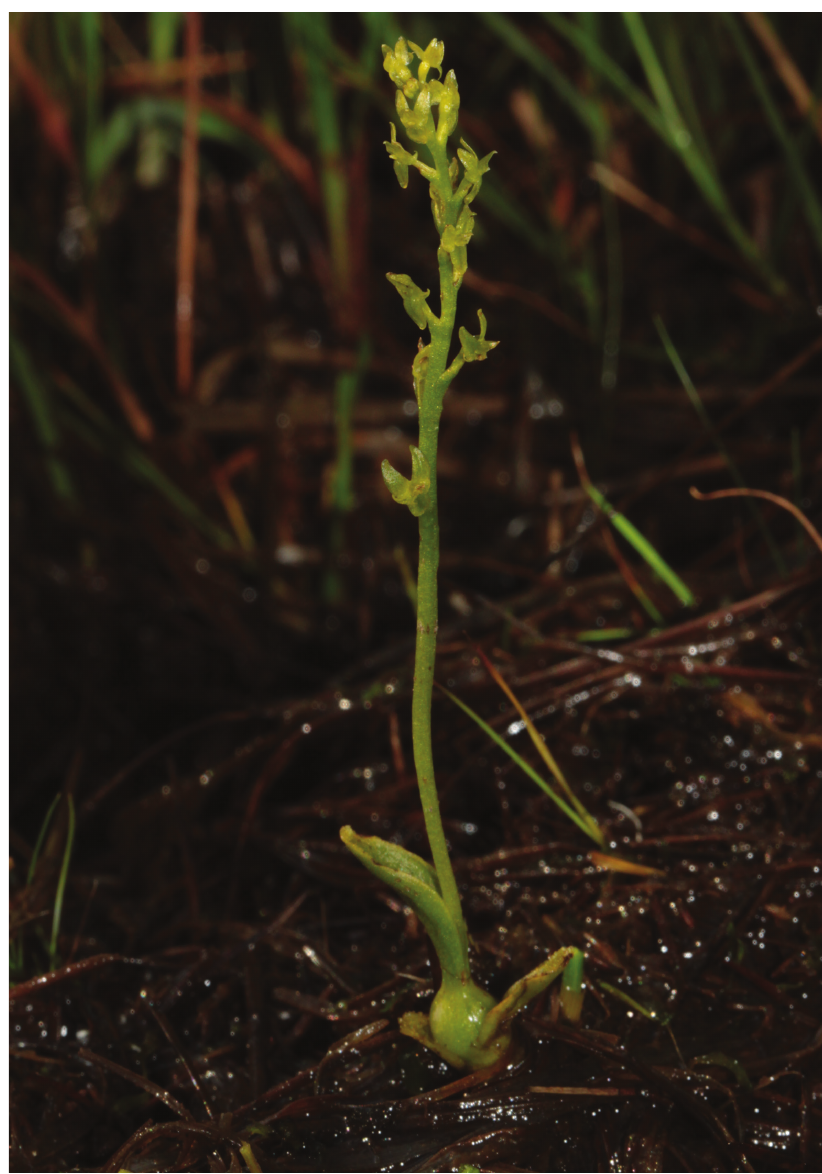
Figure 1. Hammarbya paludosa (L.) Kuntze photographed in Cinque Valli (province of Trento, Roncegno municipality) on July 19 th 2015 (photo by A.